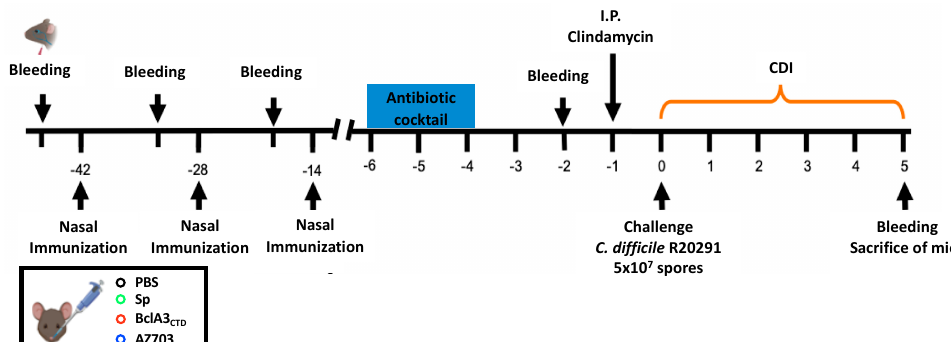
Figure 3. Schematic overview of the experimental design for the prevention of C. di ffi cile infection in a murine model. C57BL / 6 mice were nasally immunized three times (42, 28 and 14 days before challenge with C. di ffi cile R20291 spores) with PBS, spores of B. subtilis PY79, purified BclA3 CTD or spores of B. subtilis displaying the chimera protein CotB ∆ -BclA3 CTD (AZ703). Prior to the infection with C. di ffi cile R20291, the animals were submitted to an antibiotic cocktail (days 4–6 before challenge)